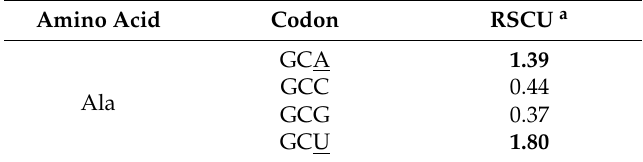
Table 1. The synonymous codon usage pattern in all open reading frames (ORFs) of S. agalactiae